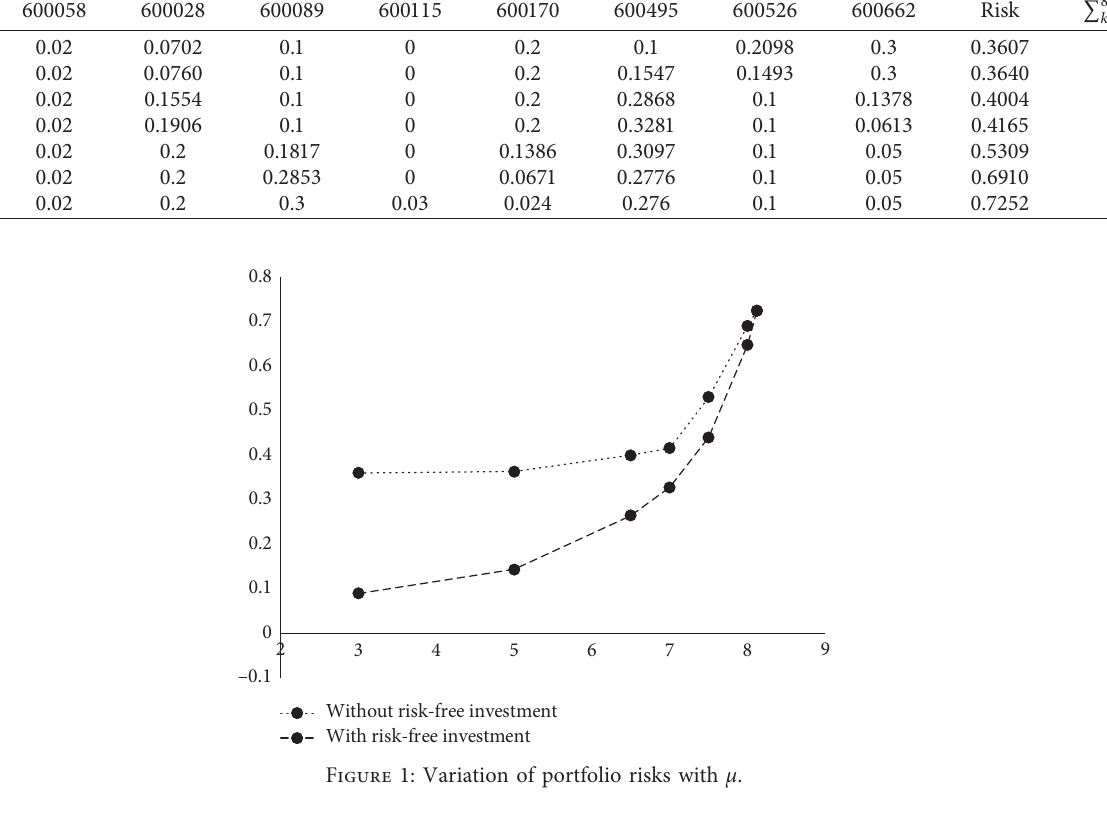
Table 4: Possibilistic efficient portfolios without risk-free investment for the different μ s with l